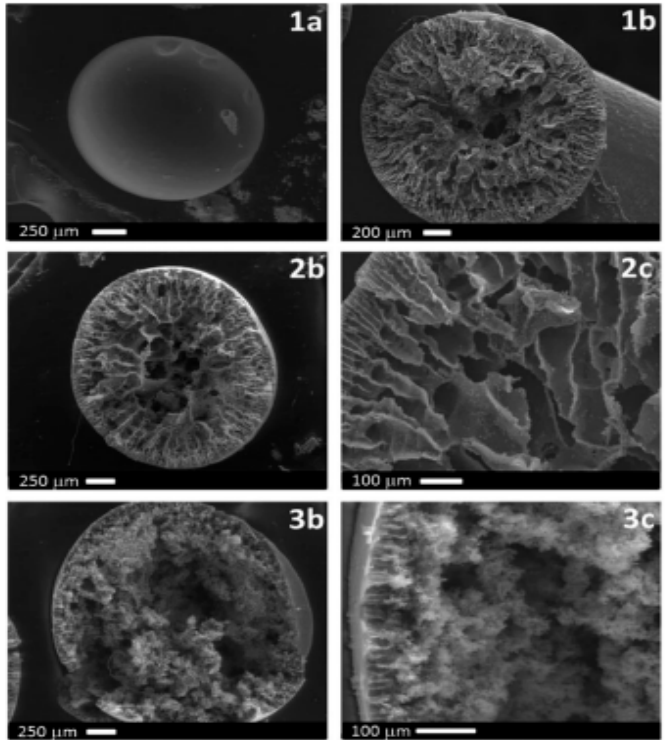
Figure 9. SEM microimages of PES microcapsules prepared by the phase inversion technique with different concentrations of [BMIM][PF6]: ( 1a ) External, ( 1b , 2b and 3b ) Cross-section, ( 2c and 3c ) Magnified cross-section (1-PES Blank, 2-PES/5 wt.% [BMIM][PF6], 3-PES/20 wt.% [BMIM][PF 6 ]) [55].